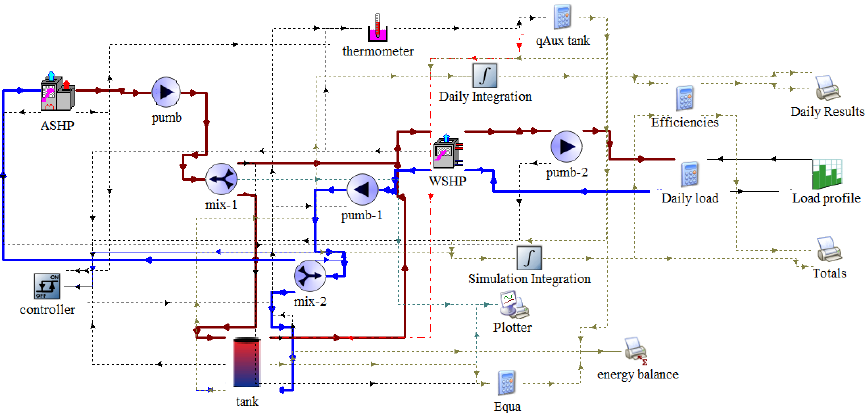
Figure 5. The simulated model.